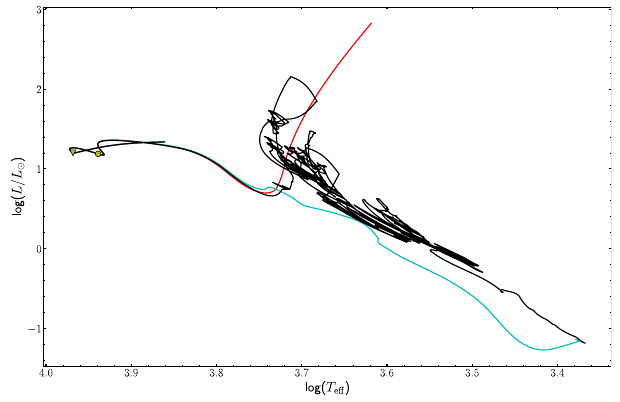
Fig. 3 | Comparison between classical, constant accreting and a selected disk- mediated model in the Hertzsprung Russel diagram. The red line shows the classical model, the turquoise line shows the constant accretion model and the black line shows the disk-mediated accretion model. The yellow circle marks the pre-de fi nedpre-mainsequence(i.e.centralcarbonmassfractiondropstoavalueof 10 − 4 )whilethe yellow trianglemarks the ZAMS (i.e. central hydrogenmass fraction has dropped by 0.01 in comparison to the initial value). All evolutionary tracks shown here have been calculated with the standard input physics.